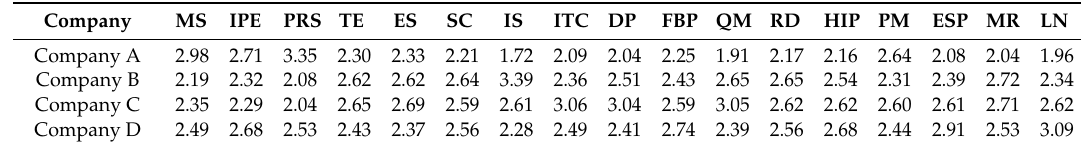
Table 3. The decision-making matrix.